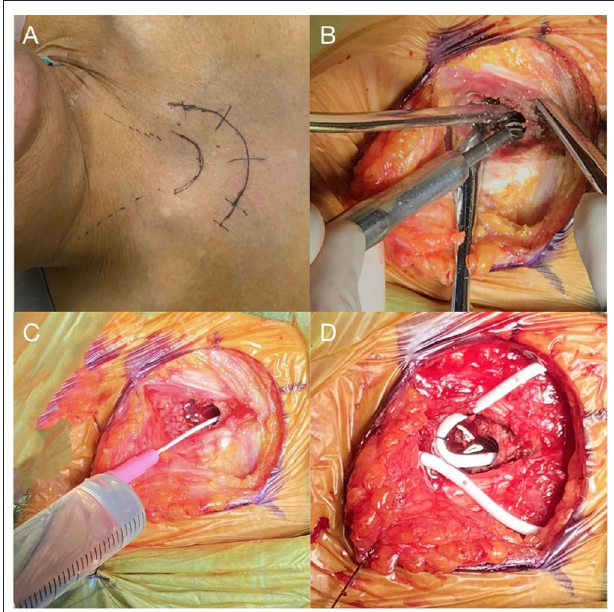
FIGURE 2 | (A) An arc skin incision for a right-sided shunt is marked. (B) Drilling of a 3cm long tunnel parallel to the long axis of the sternum at its midline. (C) Indwelling needle placement to confirm the length of the tunnel and intraosseous absorption of 10ml saline. (D) Placement of sternal catheter with a loop fixed at the sternum tendon of the sternocleidomastoid muscle.